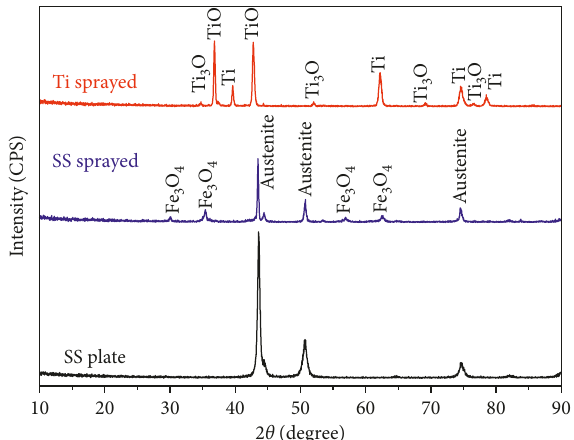
Figure 3: XRD of the SS plate and sprayed coatings by the arc thermal spray process (0.5 °